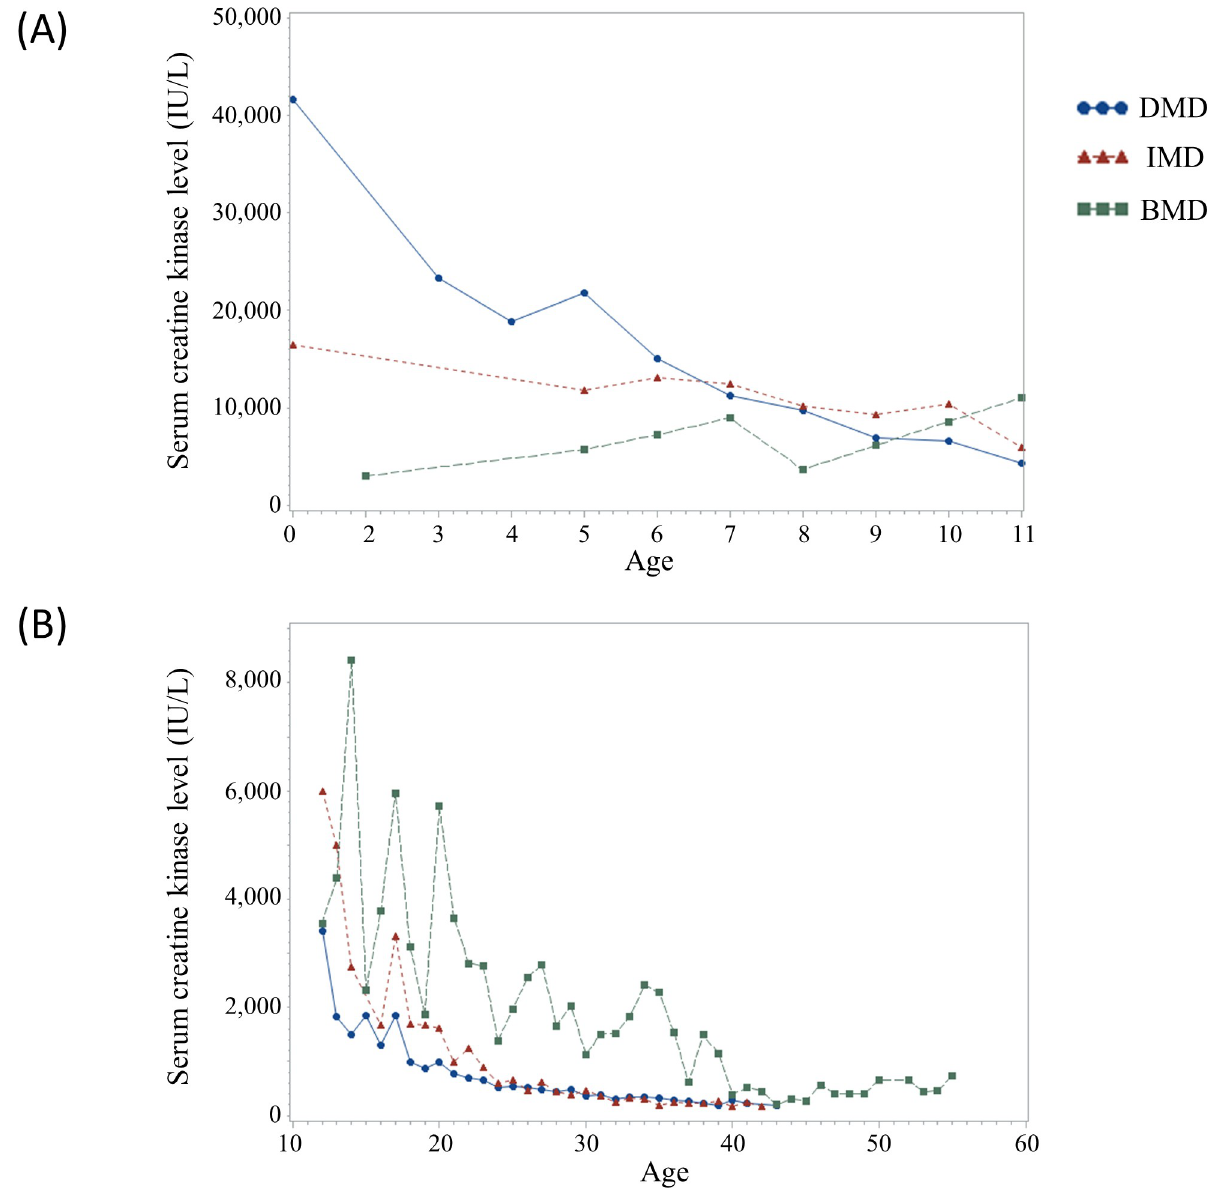
Fig 2. Changes in mean serum creatine kinase (CK) levels with age. Blue, red, and green colors indicate patients with Duchenne muscular dystrophy (DMD), intermediate phenotype muscular dystrophy (IMD), and Becker muscular dystrophy, respectively. The average annual decrease in serum creatine kinase level was significantly steeper in patients with DMD than in patients with IMD (p = 0.003) and BMD (p < 0.001). (A) Change in mean serum CK level with age for ages 0–12 and (B) change in mean serum CK level with age for ages 12 and above.